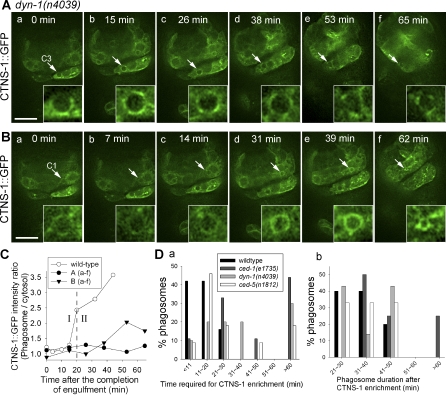
The Incorporation of CTNS-1–Labeled Lysosomes to Phagosomes Is Delayed to Different Extents in ced-1, dyn-1, and ced-5 Mutants(A and B) Time-lapse images of one dyn-1(n4039) embryo expressing Pced-1 ctns-1::gfp. Anterior is to the top. Ventral faces reader. Scale bars indicate 10 μm. Arrows indicate phagosomes. “0 min” represents when engulfment is just complete. Insets represent 4-fold enlargement of the boxed regions. (A) The C3 phagosome fails to enrich for CTNS-1 within a period of 65 min and is not degraded. (B) The enrichment of CTNS-1 on the C1 phagosome is delayed to time point “31 min.” However, it proceeds to degradation after CTNS-1 enrichment at 31 min.(C) CTNS-1 intensity ratios (phagosomal surface/cytosol) measured from (A)(a–f) and (B)(a–f) are plotted over time. CTNS-1 intensity ratio in wild-type (Figure 6C(o)) is also included. The two phases of CTNS-1 localization on phagosome surface are labeled.(D)(a) Histogram distribution of the time period it takes for CTNS-1(+) particles to be enriched on C1, C2, and C3 phagosomal surfaces, which was measured from the formation of a nascent phagosome till the phagosome surface is labeled with continuous CTNS-1 signal. Number of phagosomes monitored: wild-type: 19; ced-1: 9; dyn-1: 10; ced-5: 14. (b) Histogram distribution of phagosome durations after CTNS-1 is enriched on phagosome surface. Number of phagosomes monitored: wild-type: 10; ced-1: 8; dyn-1: 7; ced-5: 15.